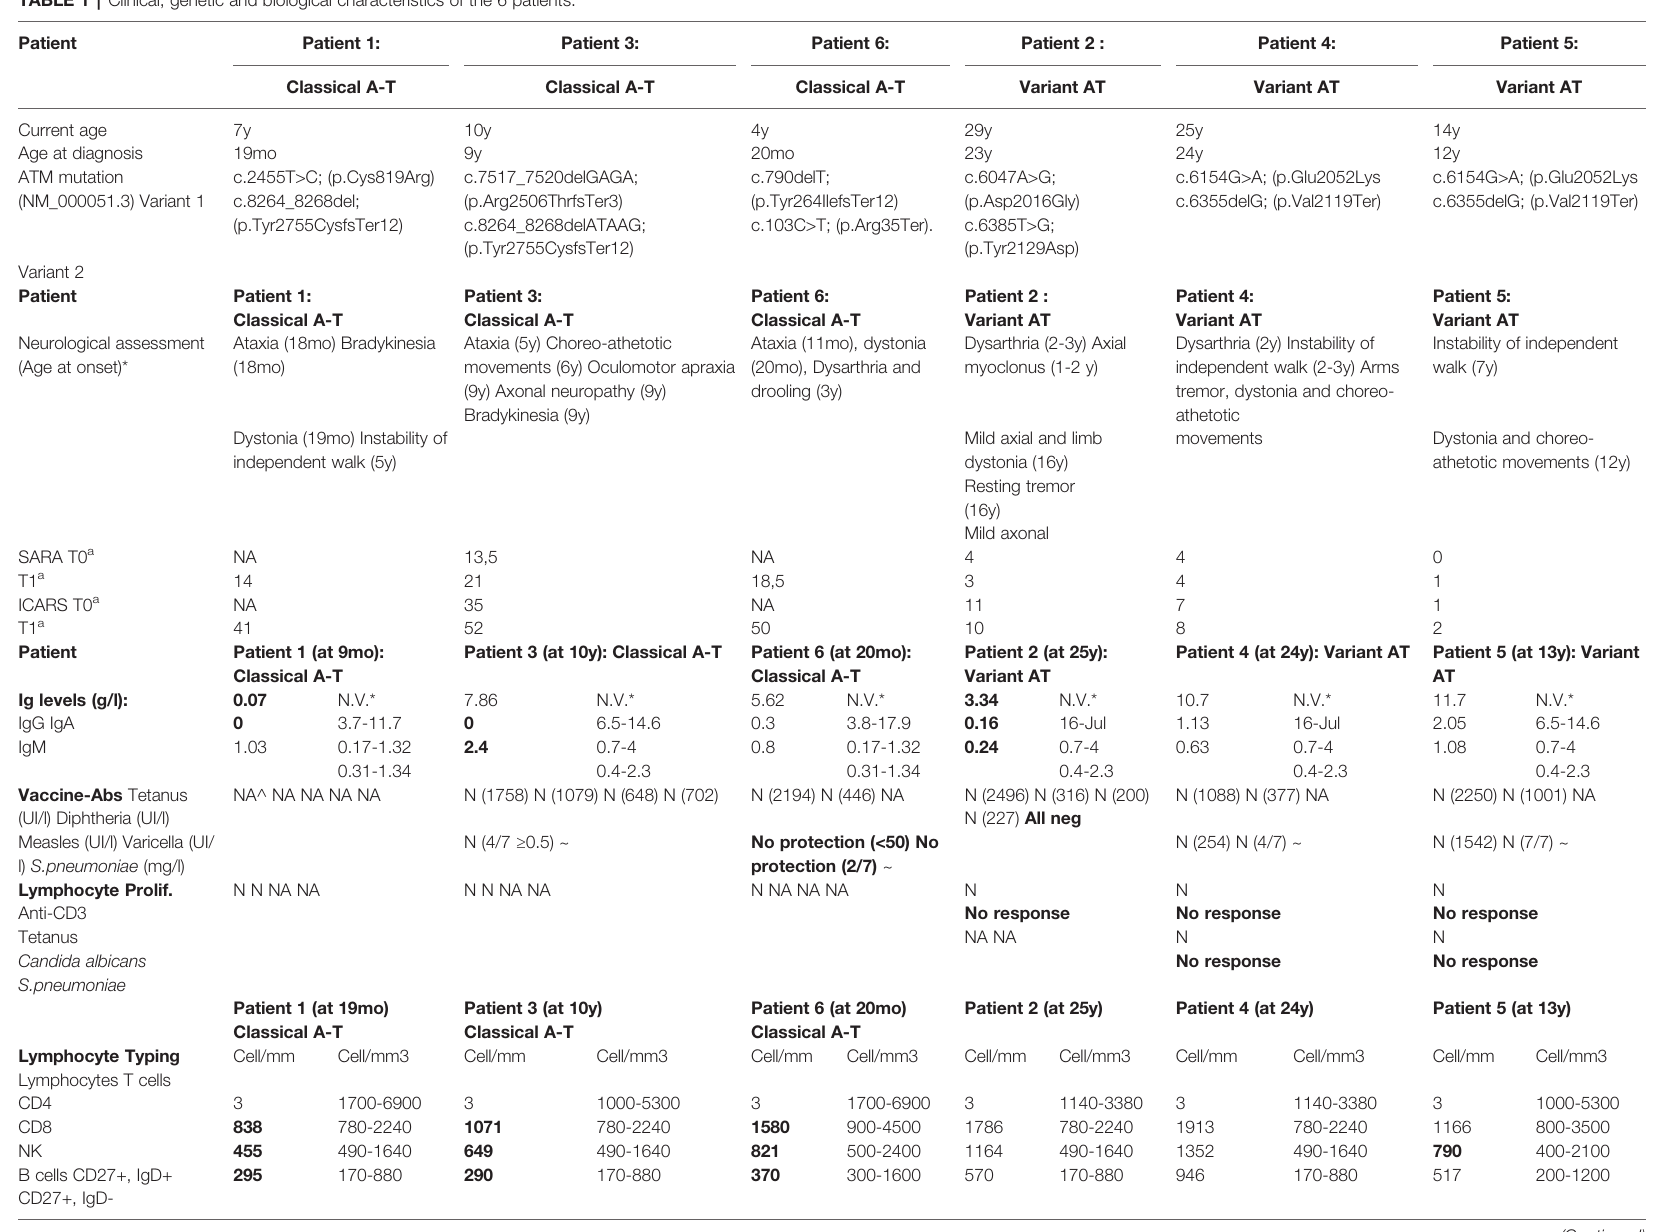
TABLE 1 | Clinical, genetic and biological characteristics of the 6